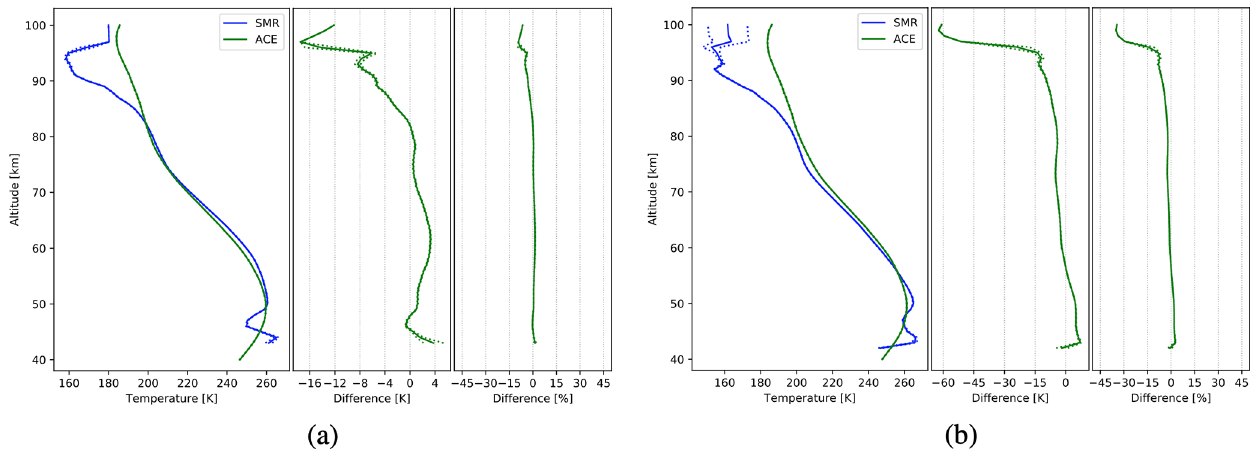
Figure A26. Comparison of SMR temperatures, from FM13 (a) and FM19 (b) , with those from ACE-FTS retrievals. The data plotted are global averages over the time period between February 2004 and April 2019. Figure characteristics are the same as in Fig. 6.